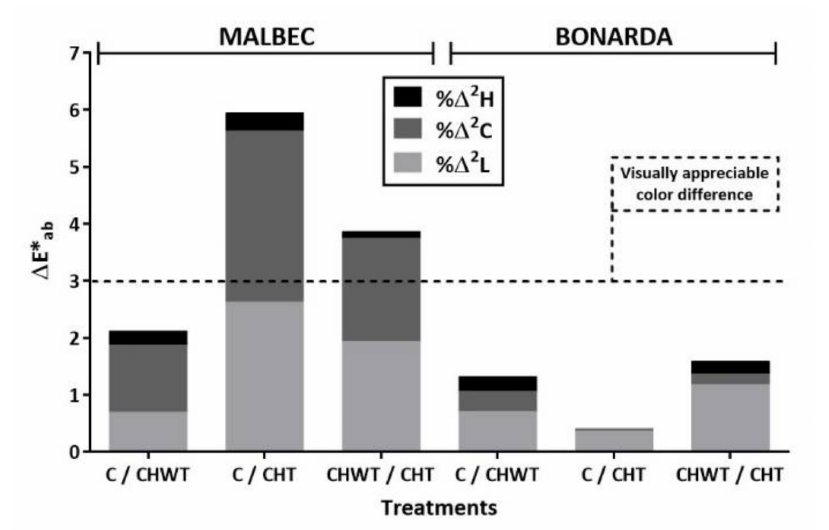
Figure 2. Color differences ( ∆ E* ab ), with the relative contributions of lightness, chroma, and hue (% ∆ 2 L, % ∆ 2 C, % ∆ 2 H), for Malbec and Bonarda wines, obtained by applying different vine-shoot treatments during winemaking. C, control; CHWT, untoasted vine-shoot chips; CHT, toasted vine- shoot